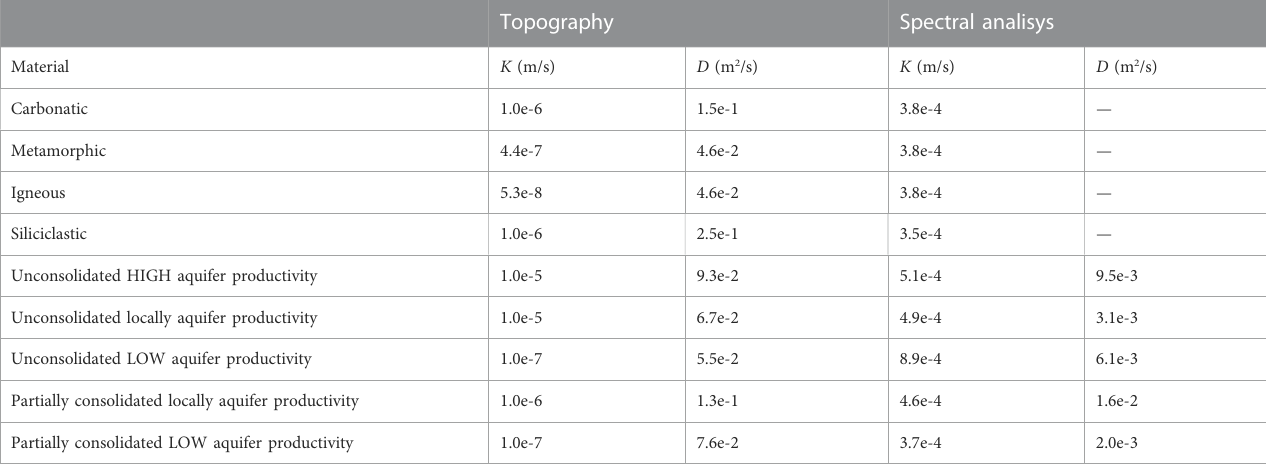
TABLE 1 Hydraulic parameters derived from the steady state calibration using as reference the topography and the spectral analyses.